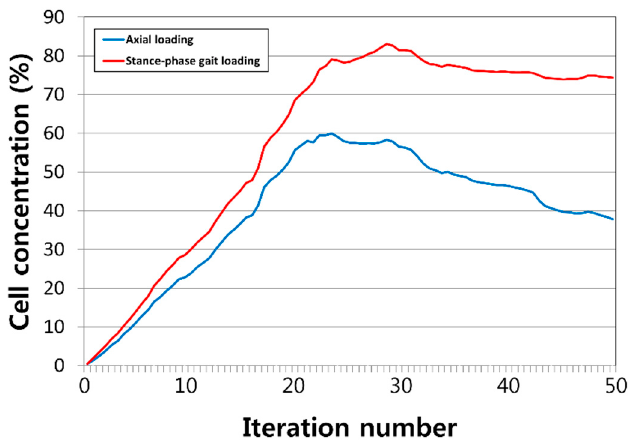
Figure 6. Comparison of the prediction of cell concentration between the axial loading and the stance-phase gait loading model.